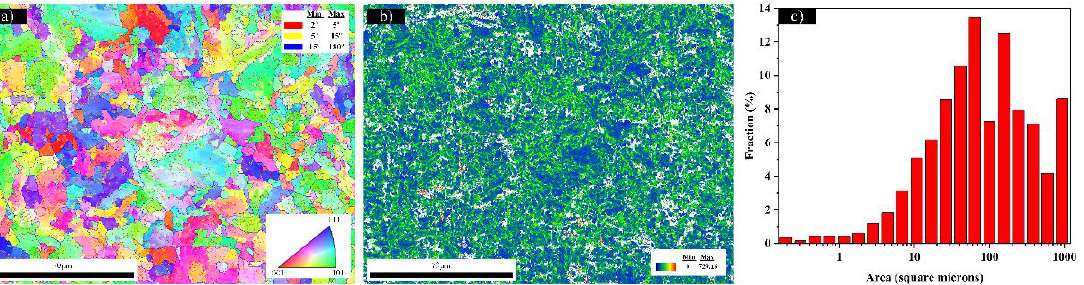
Figure 15. Microstructure information of sample B. ( a ) EBSD orientation map; ( b ) GND map; ( c ) grain area distribution.